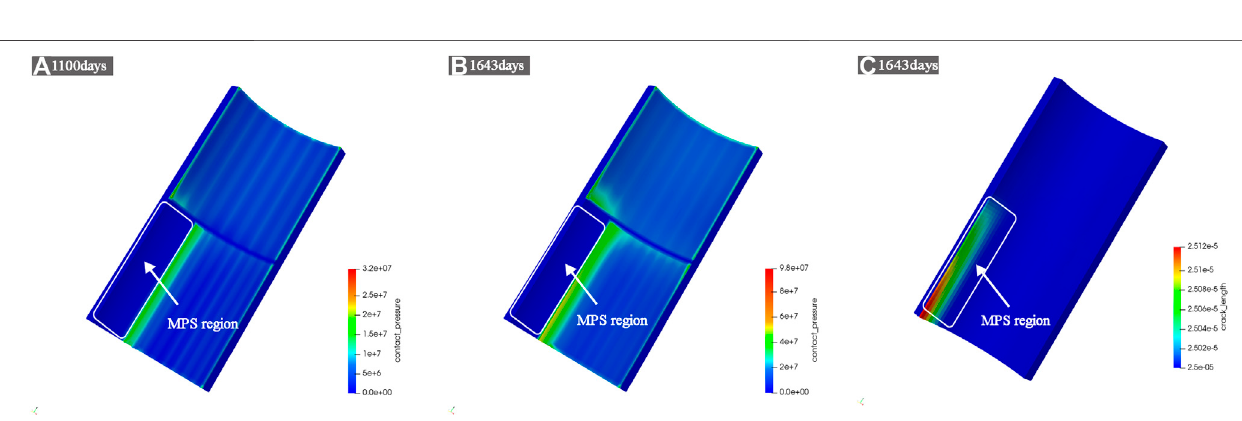
Frontiers in Energy Research |